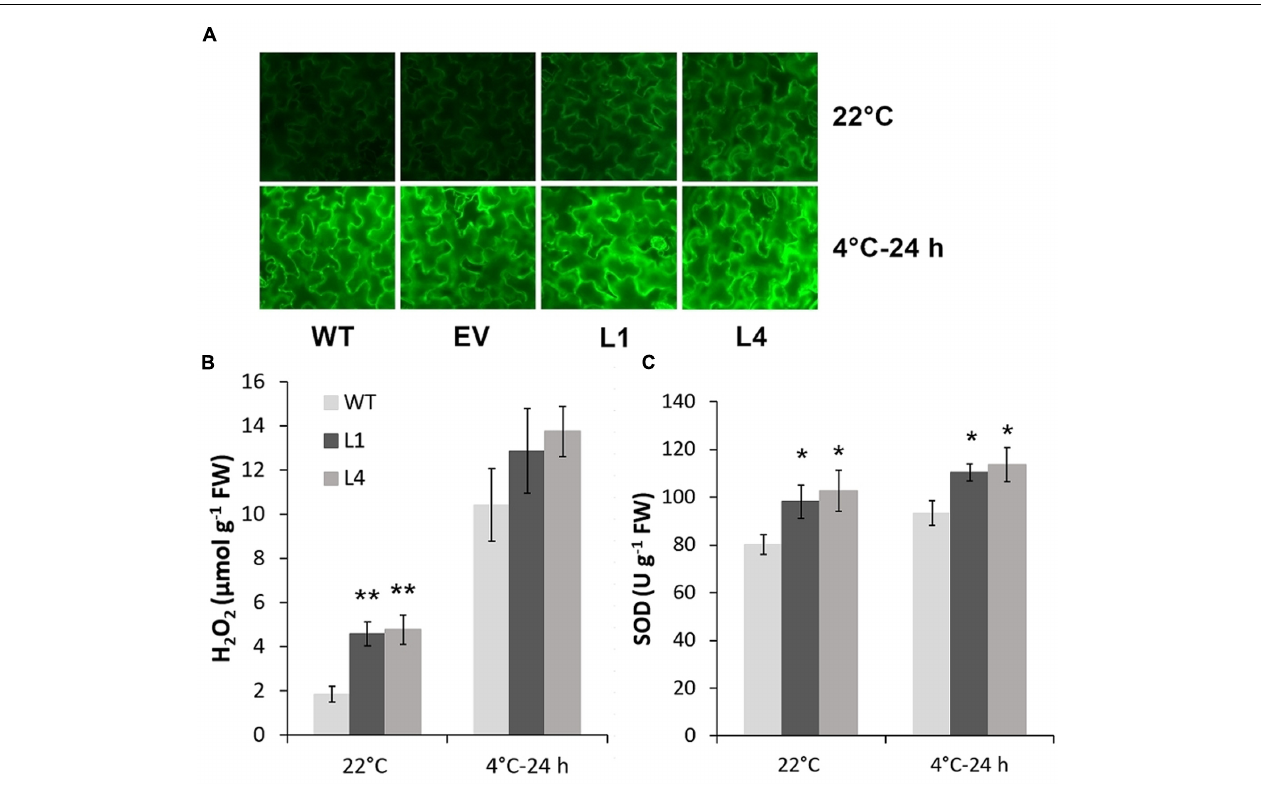
FIGURE 7 | CbRCI35 elevated tobacco ROS level in normal condition and increased SOD activity after chilling treatment. (A) ROS levels detected by Dichloro-dihydro-fluorescein diacetate (DCFH-DA) assay in 4-week-old tobacco leaf disks with or without 4 ◦ C treatment. H 2 O 2 contents and SOD activity in tobacco leaves of WT and CbRCI35-ox lines (L1 and L4) were exhibited in (B) and (C) , respectively. Error bars indicate SD ( n = 3, ∗ P < 0.05, ∗∗ P <